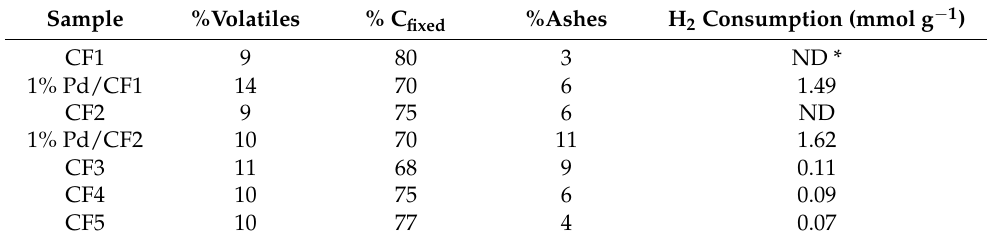
Table 2. Immediate analysis of the carbon fibers and H 2 consumption.